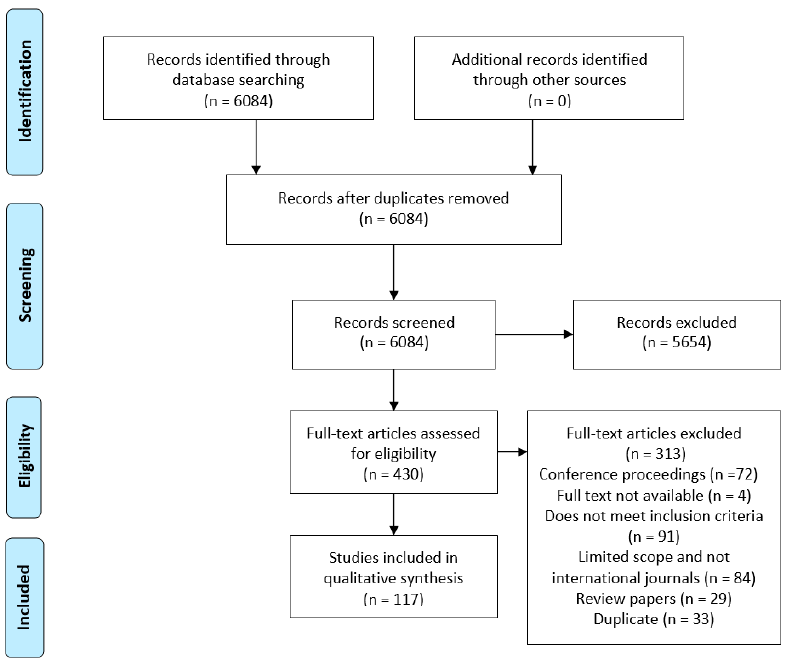
Figure 1. Preferred Reporting Items for Systematic Reviews and Meta-Analyses (PRISMA) flow chart [28] illustrating the literature search process.